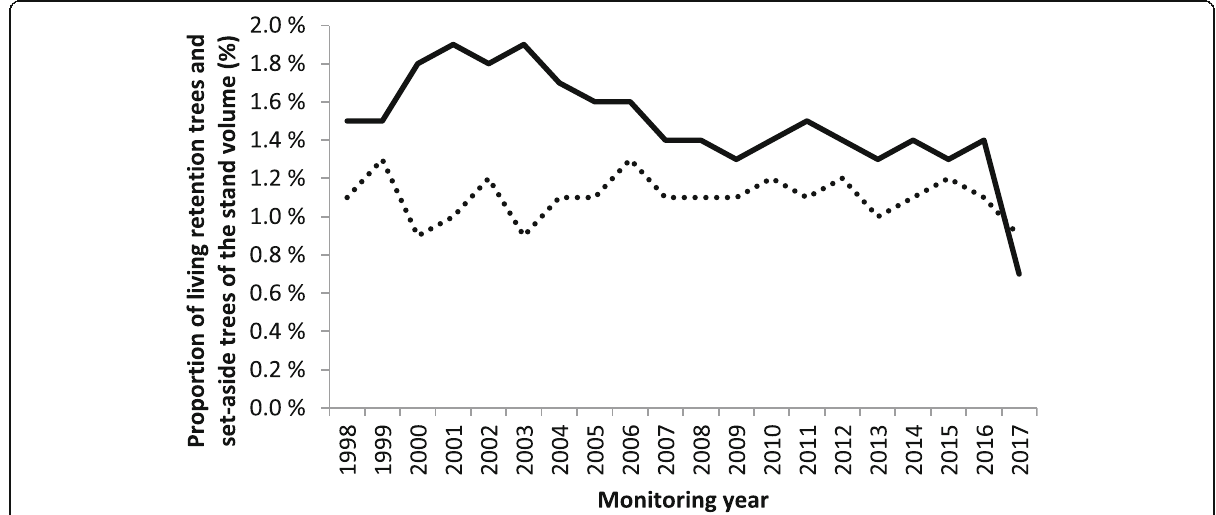
Fig. 2 Proportion of living retention trees (solid line) and living trees retained in set-asides (different types of valuable woodland key habitats, dotted line) of the stand volume (%) in 1998 – 2017 in clearcutting areas of private forests (data: Forestry Centre Tapio 2013, Finnish Forest Centre 2019). The proportion of living retention trees of the stand volume has decreased during the monitoring years from the level of the early years of PEFC certification (early 2000s) (Kendall ’ s rank correlation coefficient r K = − 0.57, p = 0.001) whereas the proportion of living trees retained in set- asides has remained the same ( r K = 0.11, p = 0.574). Thus, also the pooled proportion of living retention trees and living trees retained in set- asides of the stand volume has decreased ( r K = − 0.50, p = 0.005). Data for the year 2017 were not included in the above analyses (see text)